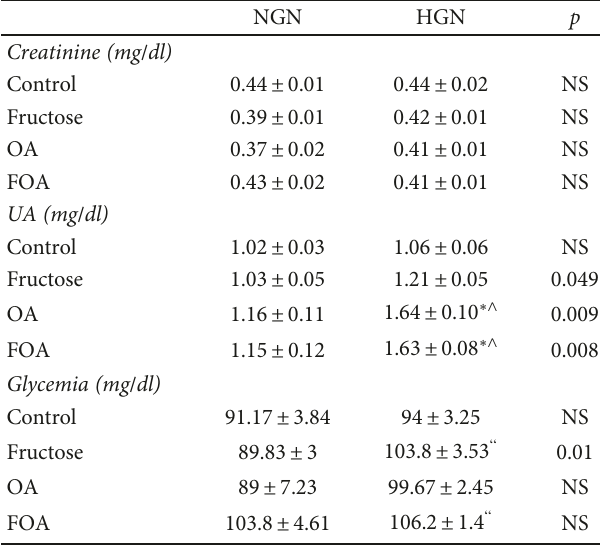
Table 4: Biochemical variables. Comparative e ff ect of the gonadal state at di ff erent stages of